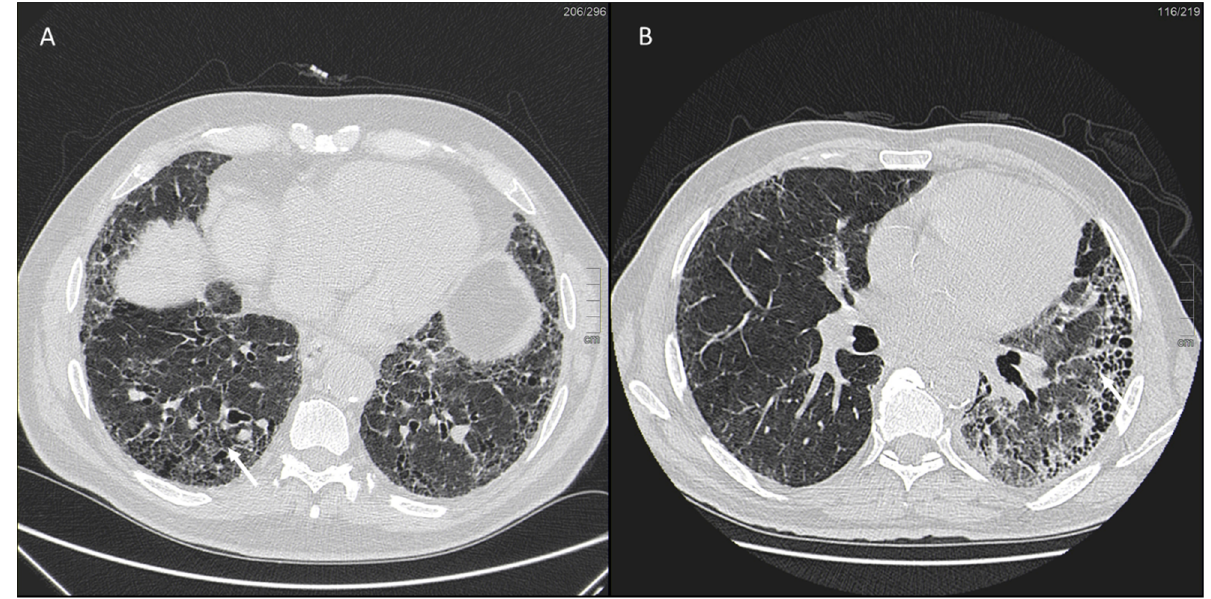
Figure 4. ( A ) Diffuse ground glass opacities with reticular thickening of the subpleural interstitium (white arrow), together with traction bronchiectasis in a case of pulmonary fibrosis with UIP pattern and smoking-related interstitial lung disease (ILD) in a female smoker. ( B ) A typical UIP pattern in a male smoker with idiopathic pulmonary fibrosis, together with diffuse ground glass opacities (white arrow) during an acute exacerbation.